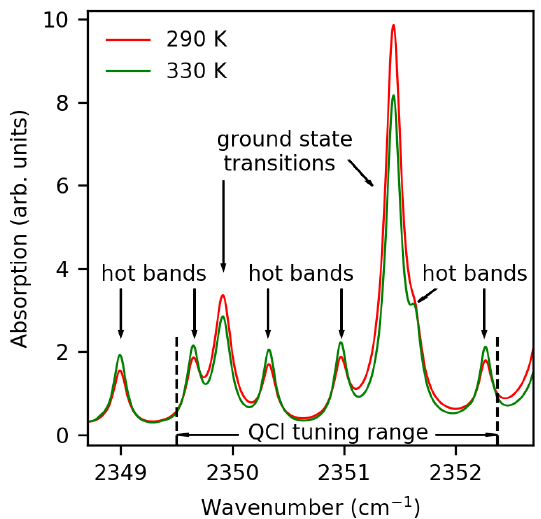
Figure 1. Absorption spectra of CO 2 gas in arbitrary units (“arb. units”) at two different temperatures based on HITRAN simulations (5% CO 2 , 95% N 2 , p = 101,325